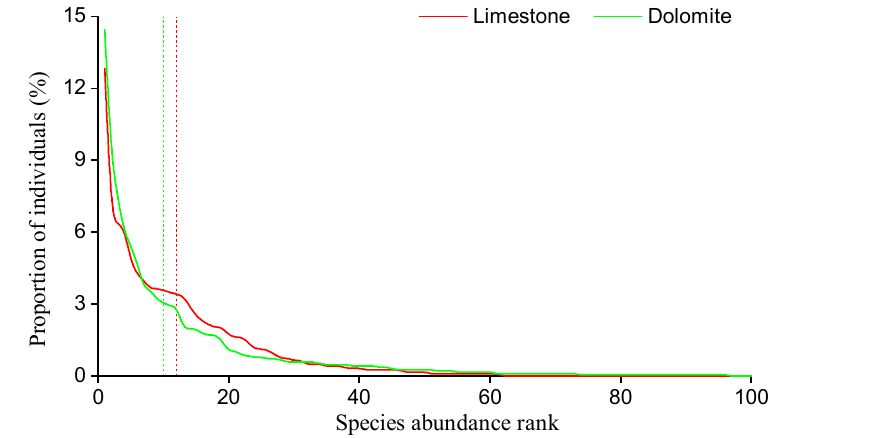
Figure 3. A rank–abundance curve of all tree species (124 species, 36 common species) studied in dolomite (n = 96 species) and limestone (n = 61 species) karst forests in Southwest China from 2017 to 2019. The most abundantly planted species account for >60% of plants and are displayed with the dashed line. The 20 most abundant tree species can be found in the Supplementary Materials.